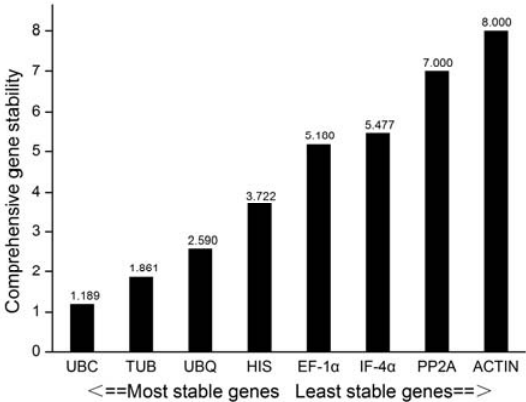
Figure 5. RefFinder comprehensively analyzed the expression stable level of eight candidate reference genes during different development stages of B. juncea.